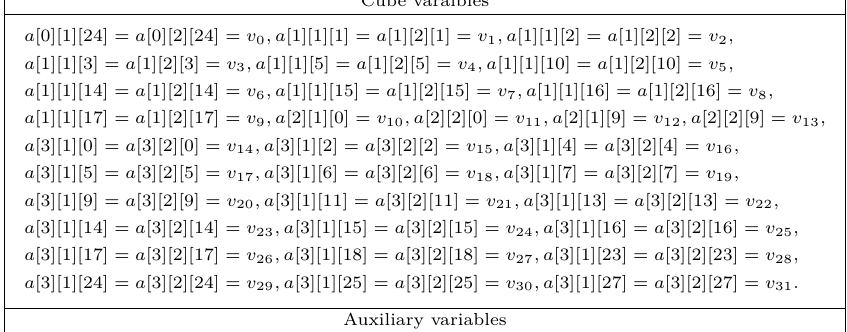
Table 15: A 32-dimensional cube for the Xoodoo AE, where ( n a , n i ) = (55 , 55). In total, there are 106 bits key information involved in both auxiliary variables and involved key